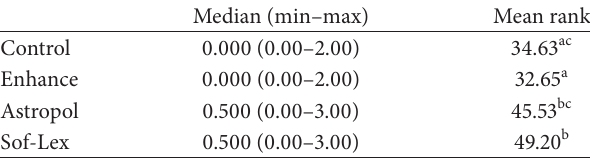
Table 5: Comparison of medians (minimum–maximum) and mean ranks of microleakage according to the different finishing and polishing systems studied, in the dentin